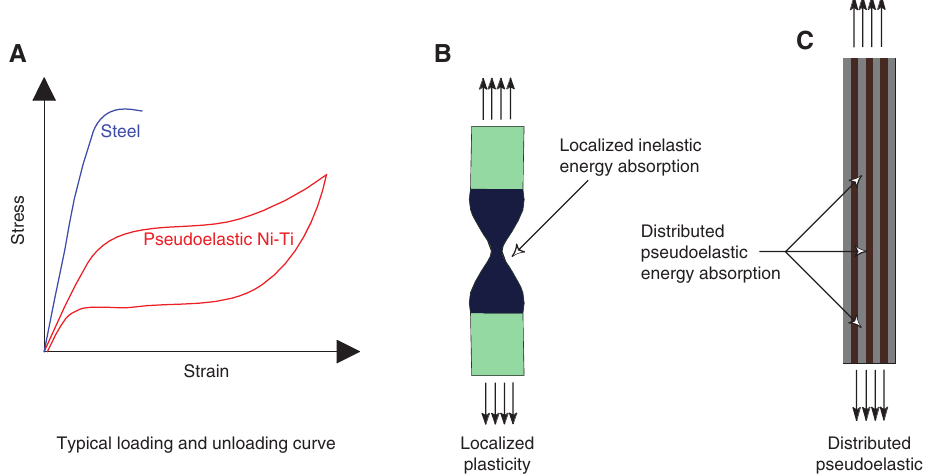
Figure 2 Pseudoelastic constitutive behavior, and the localized nature of plasticity versus the distributed nature of